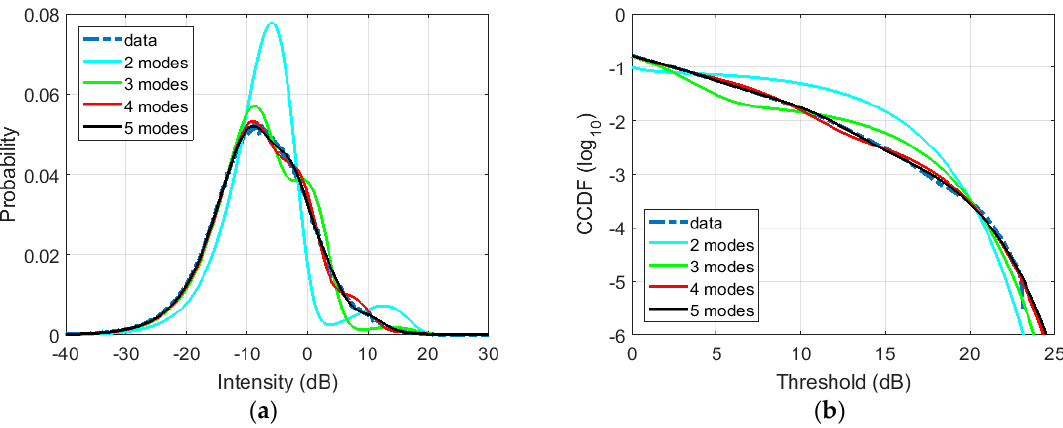
Figure 8. Model fits for the 3MD distribution with different numbers of modes using the NetRAD data S-band, VV-polarization, bistatic configuration, 60° bistatic angle (Run 1). Illustrations show the ( a ) PDF, ( b ) CCDF.